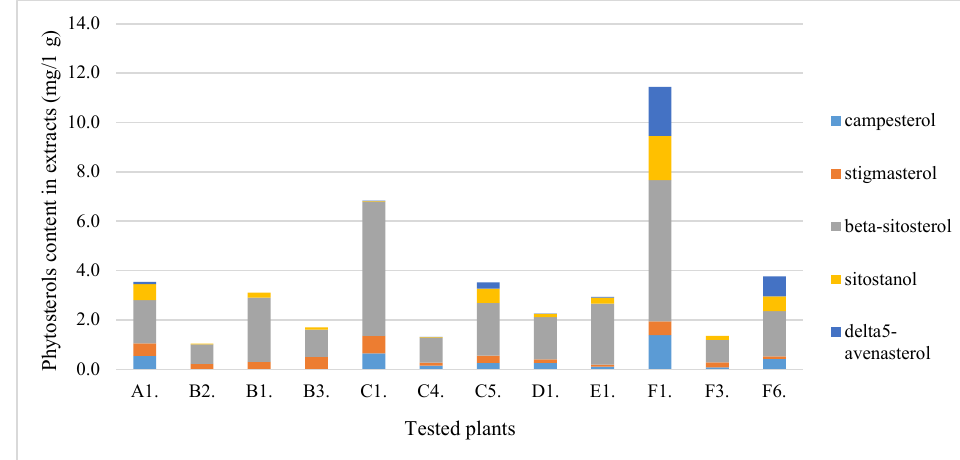
Figure 3. The content of sterols in the plants tested.